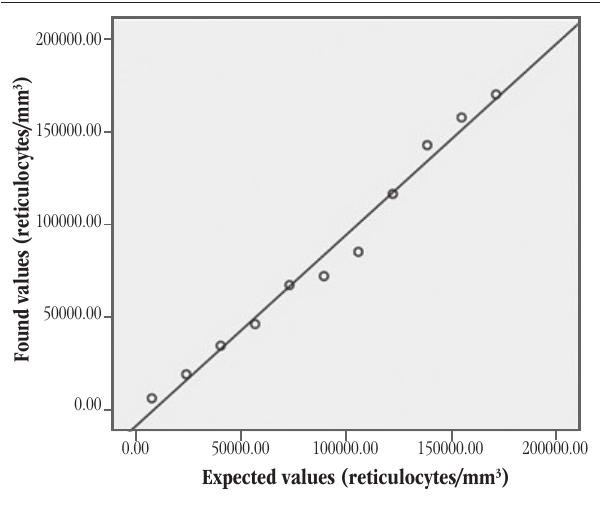
figurE 4 – Linearity of the FC reticulocytes enumeration method (BD FACSCaliburTM), using AO (new protocol)